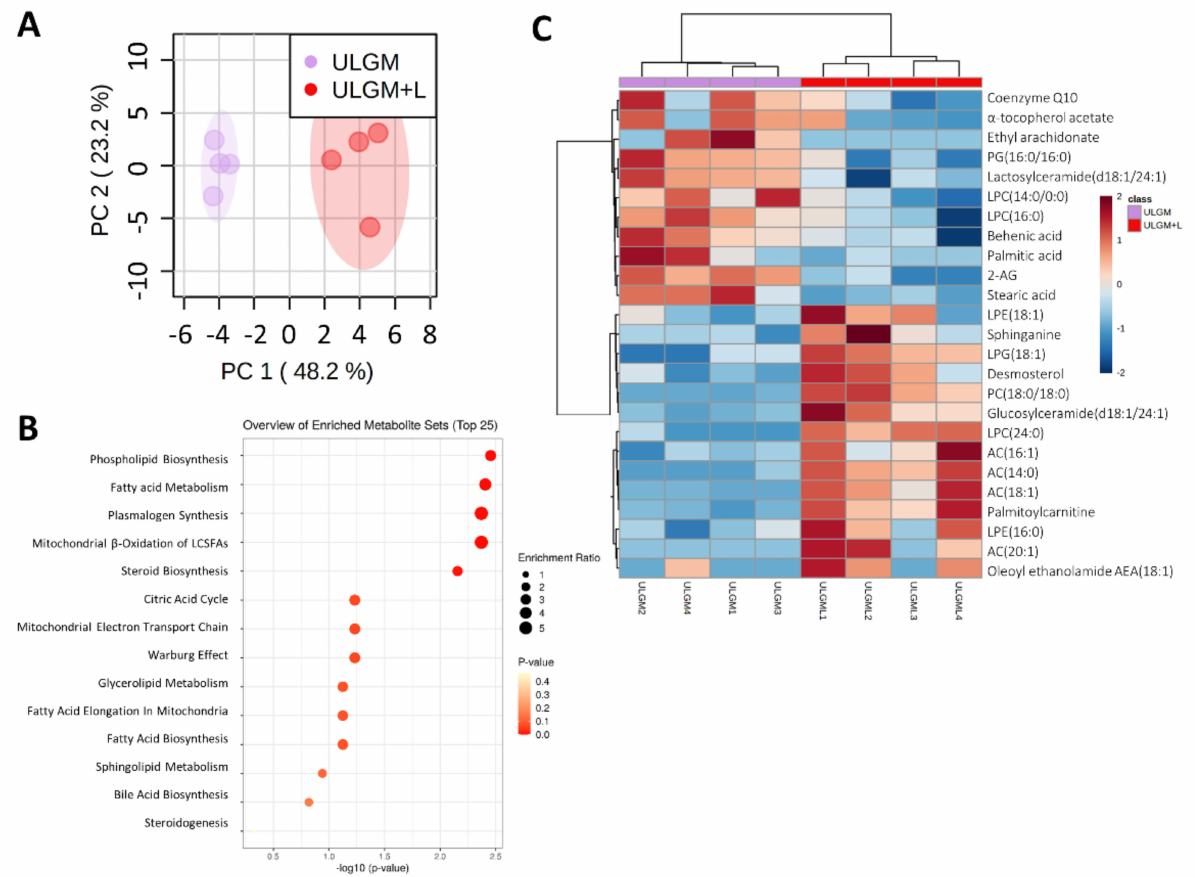
Figure 5. Lactate reprograms lipid metabolism in glucose-deprived GSCs. ( A ) Principal component (PC) analysis of lipid metabolite levels measured by liquid chromatography and mass spectrometry in TSH-N5 cells cultured for 6 days in ULGM with or without 4 mM lactate. ( B ) Metabolite enrichment analysis for TSH-N5 cells as in ( A ). ( C ) Heat map for the top 25 significantly different metabolites measured as in ( A ). Metabolite levels were quantified for four biological samples for each condition. Data were scaled by mean-centering followed by division by the SD for each variable. Differences between groups in ( C ) were analyzed with the unpaired two-tailed Student’s t